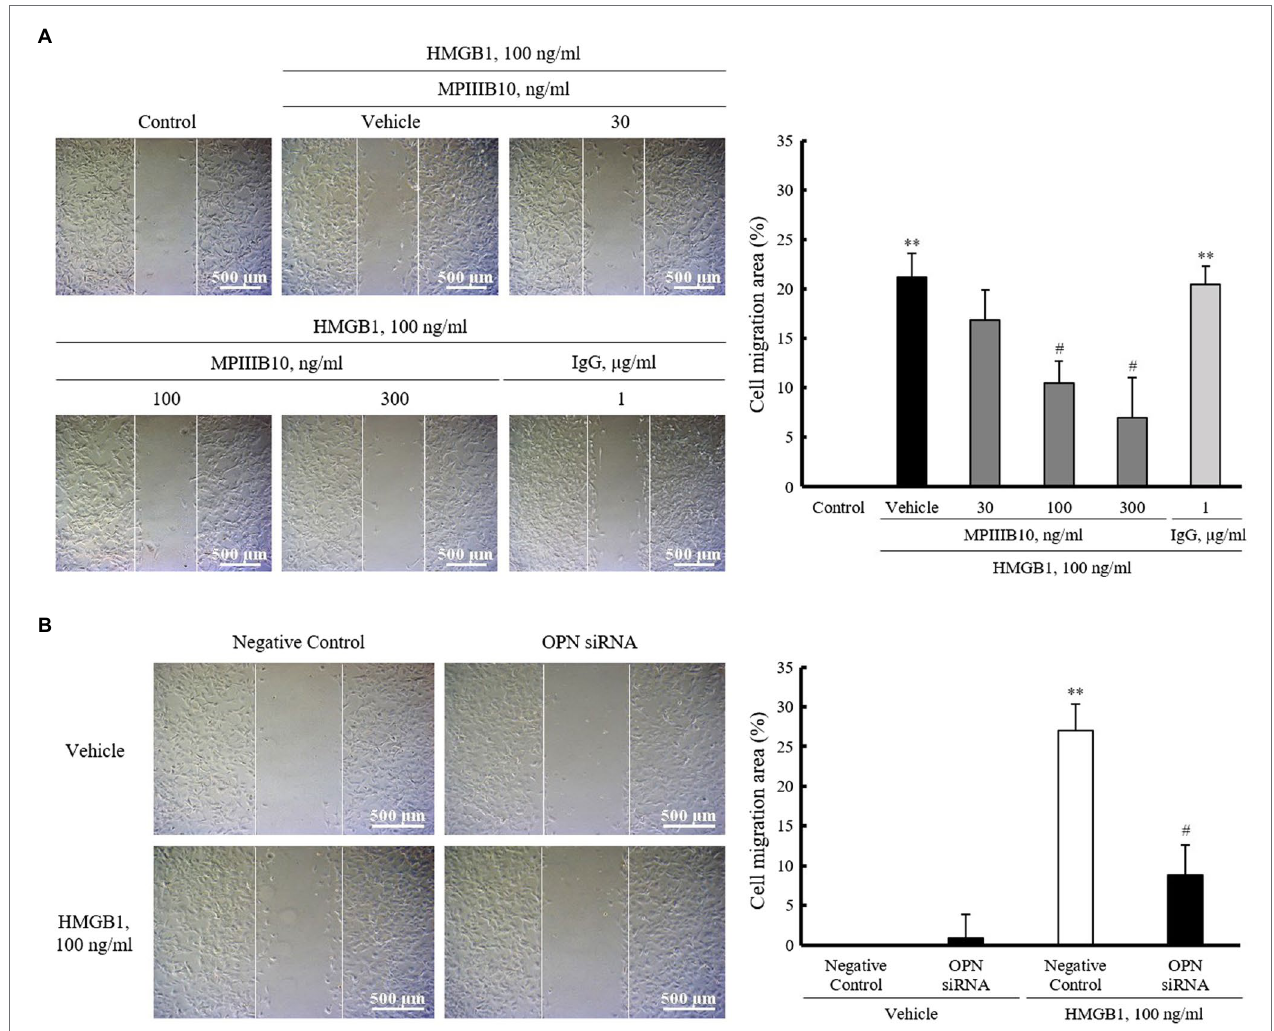
FIGURE 3 | The role of OPN on HMGB1-induced VSMC migration. (A) VSMCs were pretreated with MPIIIB10 (30 to 300 ng/ml) or IgG (1 μ g/ml) for 1 h and then stimulated with HMGB1 (100 ng/ml) for 48 h. Cell migration was determined by wound-healing assay. Cell migration area (%) was calculated from the ratio of changes in wound area. Scale bar: 500 μ m. Data were quantified, expressed as the mean ± SEM of five independent experiments. ** p < 0.01 vs. value in control and # p < 0.05 vs. corresponding value in vehicle. (B) VSMCs were transfected with negative control siRNA or OPN siRNA (200 nM) for 48 h and then stimulated with HMGB1 (100 ng/ml) for 48 h. Cell migration was determined by wound-healing assay. Cell migration area (%) was calculated from the ratio of changes in wound area. Scale bar: 500 μ m. Data were quantified, expressed as the mean ± SEM of four independent experiments. ** p < 0.01 vs. value in negative control in vehicle and # p < 0.05 vs. corresponding value in negative control in